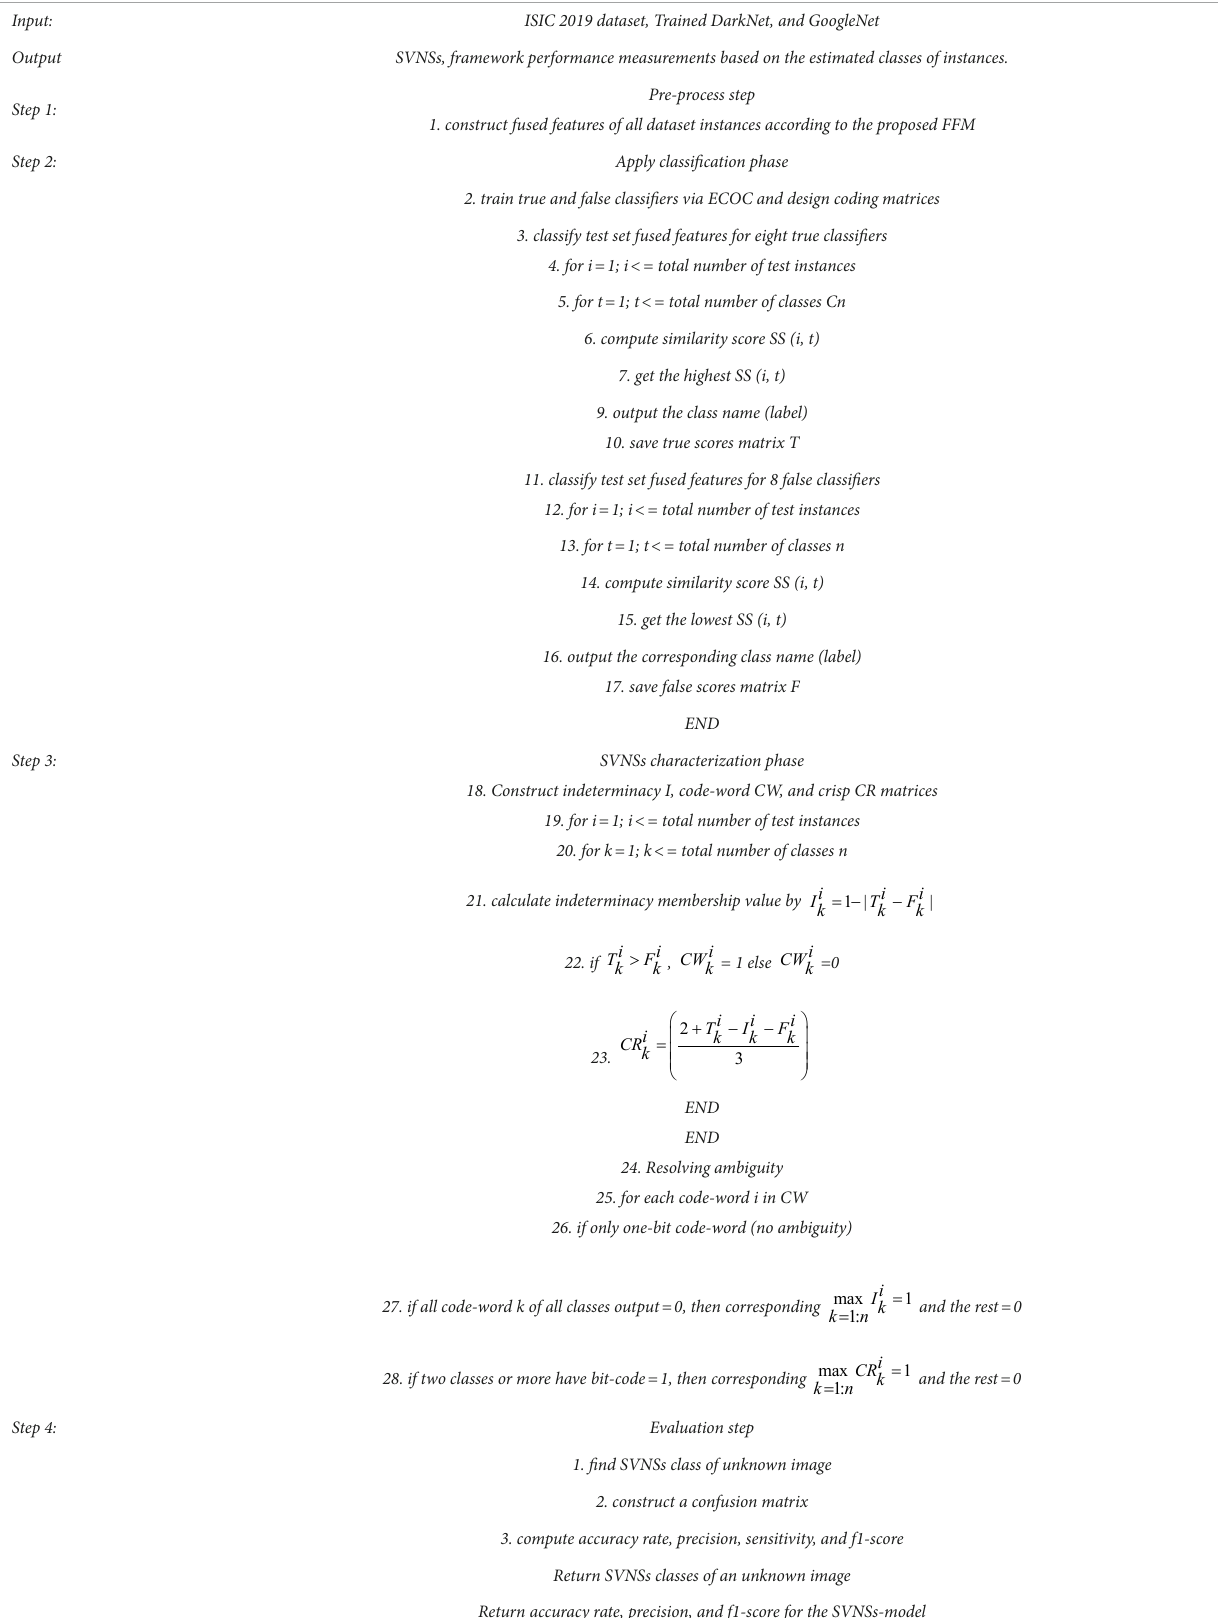
Algorithm 1 The pseudo-code of the proposed